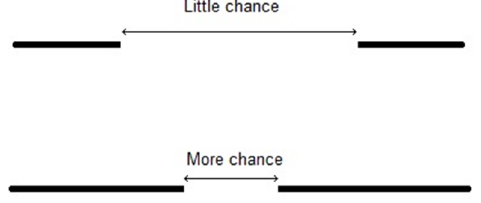
Figure 6. Distance parameter